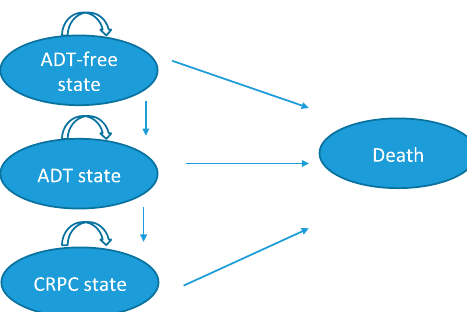
Figure 7. Markov model summarizing the state transitions (simplified model). Patients treated by MDT or surveillance enter the Markov model in the ADT-free state. Patients that are treated with immediate ADT enter the Markov model in the ADT state. Circles represents the di ff erent health states in the model. Arrows represent transitions between health states, Patients are at each health state at risk for developing side e ff ects. ADT: Androgen-deprivation therapy; CRPC: Castration-resistant prostate cancer; MDT: Metastasis-directed therapy.